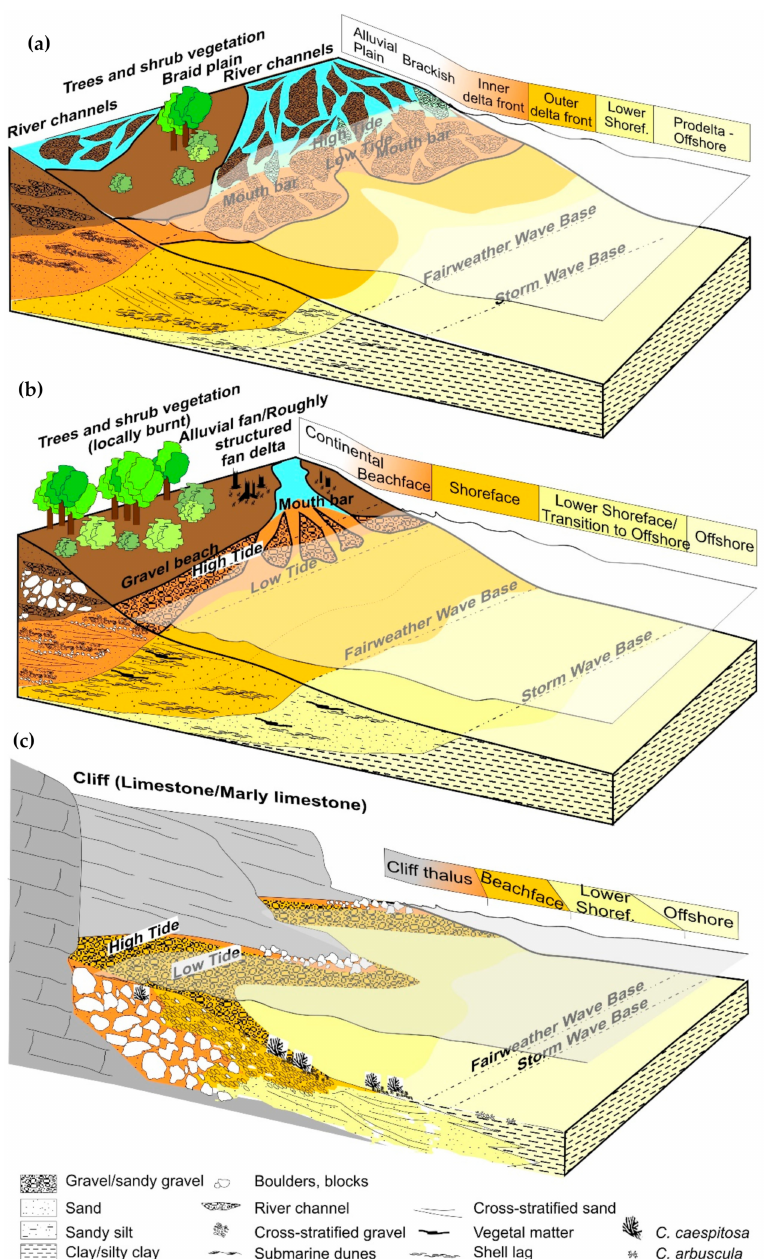
Figure 5. Early Pleistocene 3D facies models (block-diagrams) for the Valdichiana Basin. ( a ) Braid-delta system; ( b ) Gravel beach systems; ( c ) Rocky